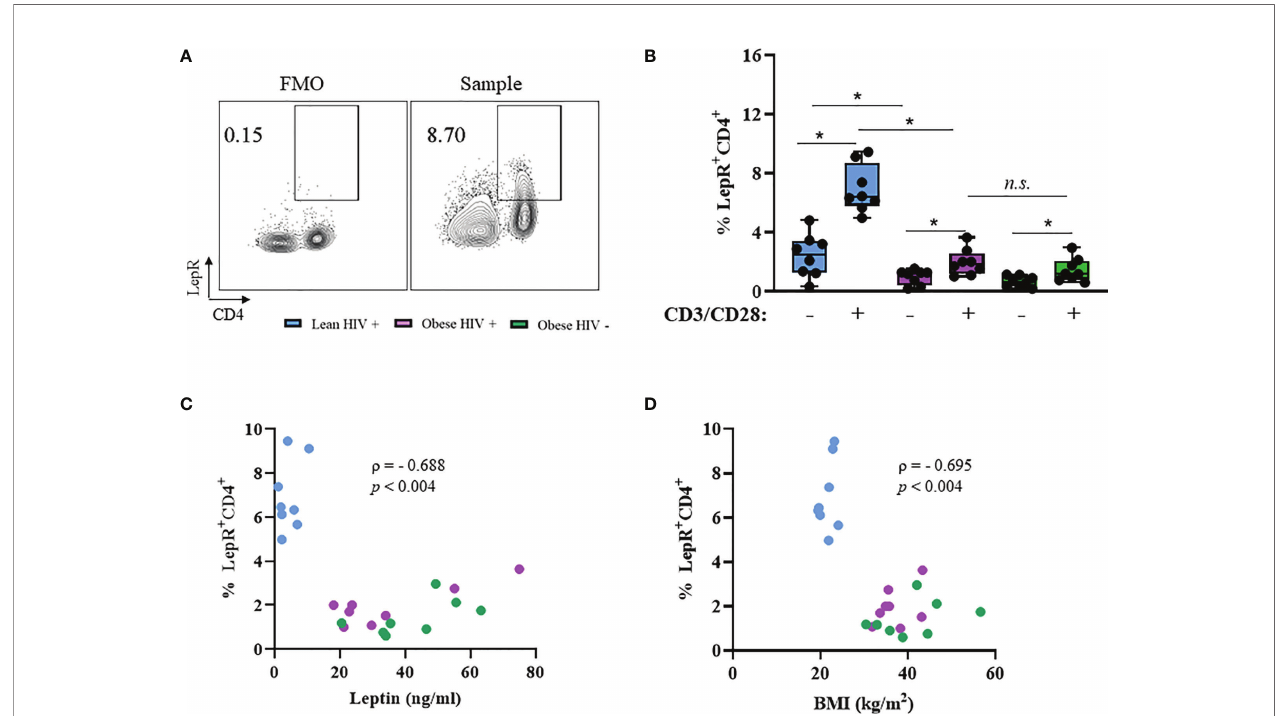
FIGURE 3 | Leptin receptor expression is decreased in CD4 + T cells from obese PLWH compared to lean PLWH. PBMCs from obese and lean PLWH, as well obese HIV negative controls, were stimulated with anti-CD3/CD28/CD49d for 2 days. (A) Representative fl ow gating of leptin receptor (LepR) surface expression in CD4+ T cells following activation. (B) Quanti fi cation of the percentage of LepR+CD4+ T cells. Relationship between percentage of LepR+CD4+ cells and (C) plasma leptin levels or (D) by BMI. In (B) , Mann-Whitney tests were used to compare obese and lean PLWH, or obese PLWH and obese HIV negative controls. n = 8-9 persons per group. * p < 0.05 was considered statistically signi fi cant. Data shows one representative experiment repeated three times. n.s . means not statistically signi fi cant. In (C, D) , Spearman ’ s rank correlations were conducted for plasma leptin and BMI